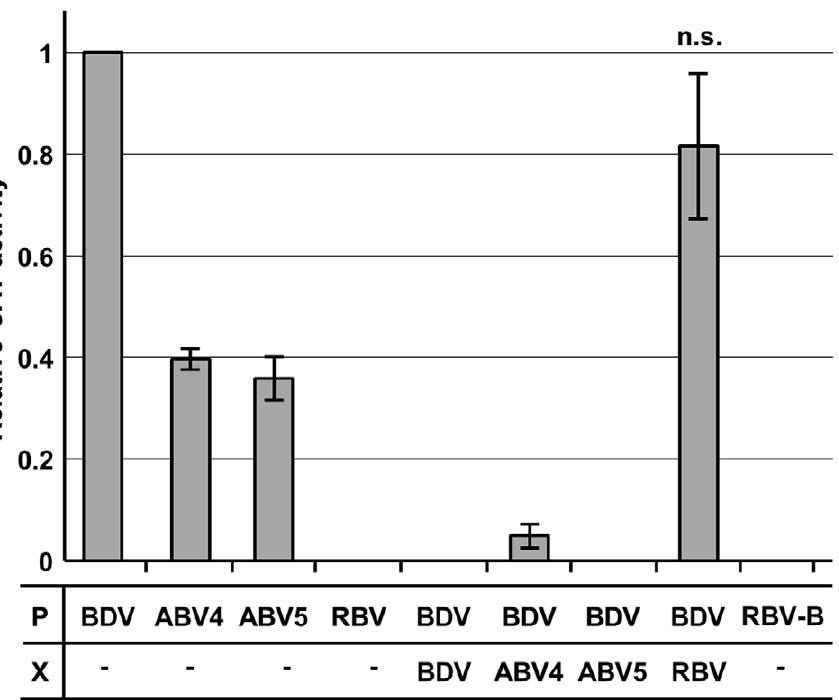
Figure 7. Compatible function of ABV X and P in a BDV minireplicon assay. BDV minireplicon assays were performed using the expression plasmids indicated, together with 0.125 ng of the minigenome construct and helper plasmids expressing BDV N (0.125 ng) and L (0.125 ng). The graph shows the mean 6 SE of three independent experiments. At least three independent experiments were performed, except for RBV-B- transfection assay (n=2). The differences were statistically significant ( P , 0.01, student t test), except for the assay using RBV X and RBV-BP. n.s., not significant.